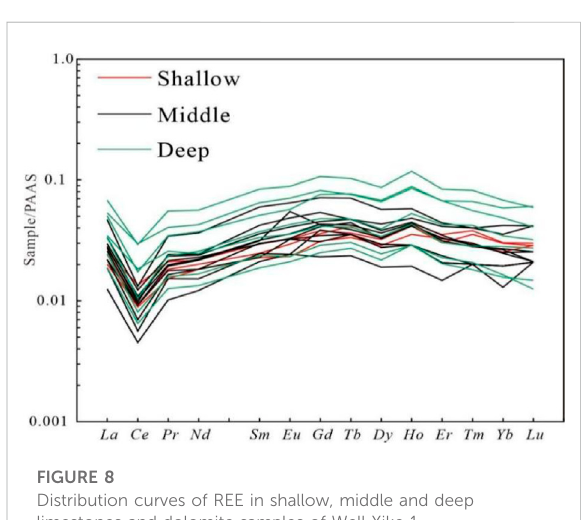
Distribution curves of REE in shallow, middle and deep limestones and dolomite samples of Well Xike